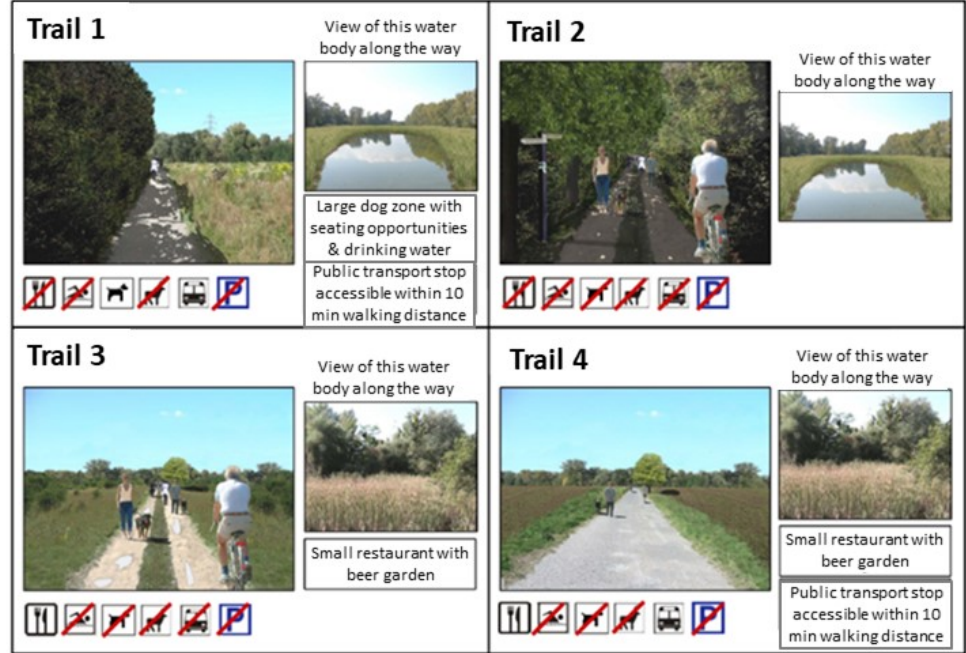
Figure 4. Example of a choice set. Each choice set was printed on A3 paper. Each respondent viewed 4 out of 64 choice sets and was asked to choose the most and least preferred scenario from each set.